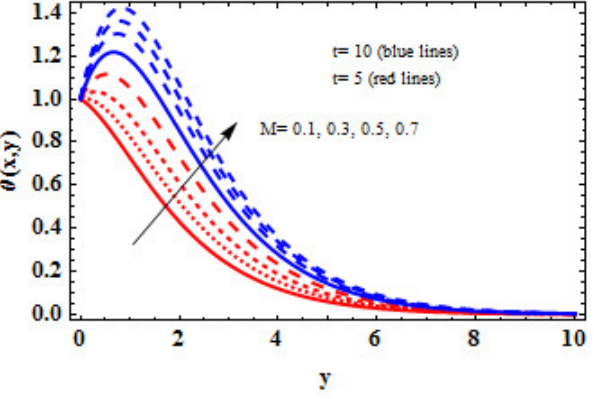
Figure 9. M effect on temperature with respect to time.